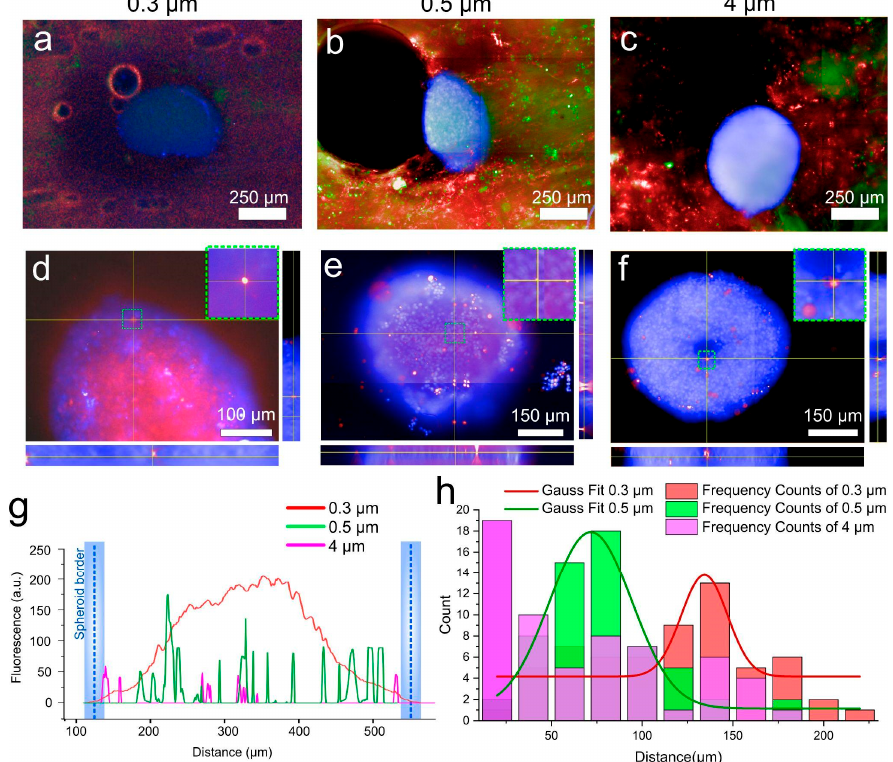
Figure 4. ( a – c ) Fluorescence images of chip with 4T1 cell tumor spheroid (Hoechst, blue fluorescence), T lymphocyte cells (Calcein Am, green fluorescence), and ( a ) 0.3, ( b ) 0.5 and ( c ) 4 μ m polymer capsules (Cy5, red fluorescence). ( d – f ) Orthogonal fluorescence images of cell spheroids with internalized ( d ) 0.3, ( e ) 0.5 and ( f ) 4 μ m capsules. ( g ) Photographed fluorescence profiles for cell spheroids with internalized capsules of 0.3, 0.5 and 4 μ m. The fluorescence brightness profile along the dashed yellow line in ( d – f ), which shows the fluorescence distribution of capsules 0.3 (red), 0.5 (green), and 3.5 (purple) in the cell spheroid, the borders of which are marked with blue. ( h ) The distribution of the capsule’s penetration depth.